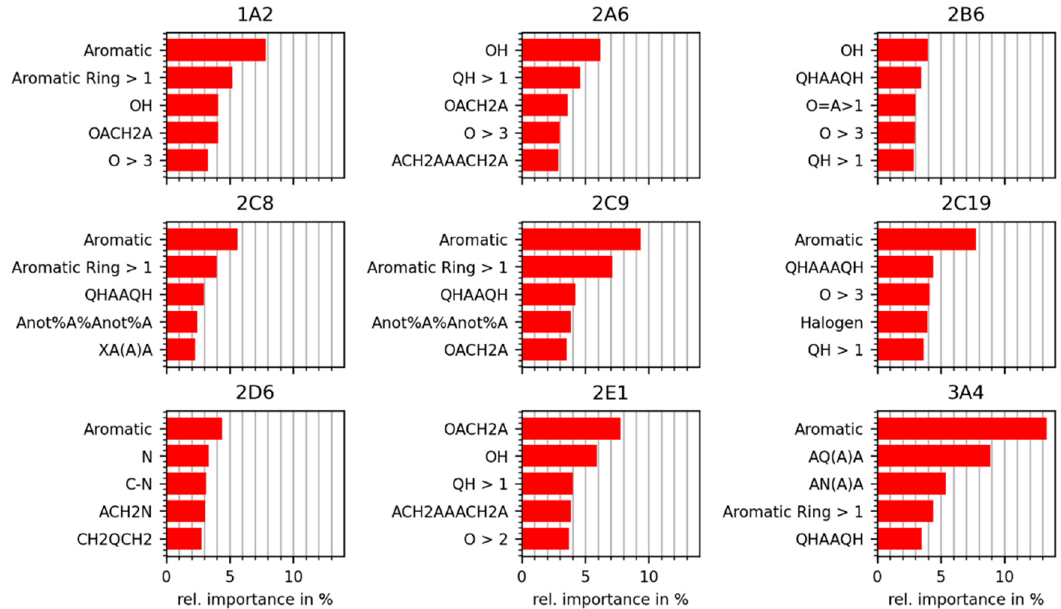
Figure 6. Relative feature importance values (calculated as Gini importance) of the five most relevant MACCS keys identified during 5-fold CV by the best RF classifiers (by MCC) trained on MACCS keys. In the reported patterns, “A” denotes any atom, “Q” denotes an atom that is not carbon or hydrogen, “X” denotes any halogen atom, “%” denotes an aromatic bond, and “not%” denotes a bond that is non ‐ aromatic [29].